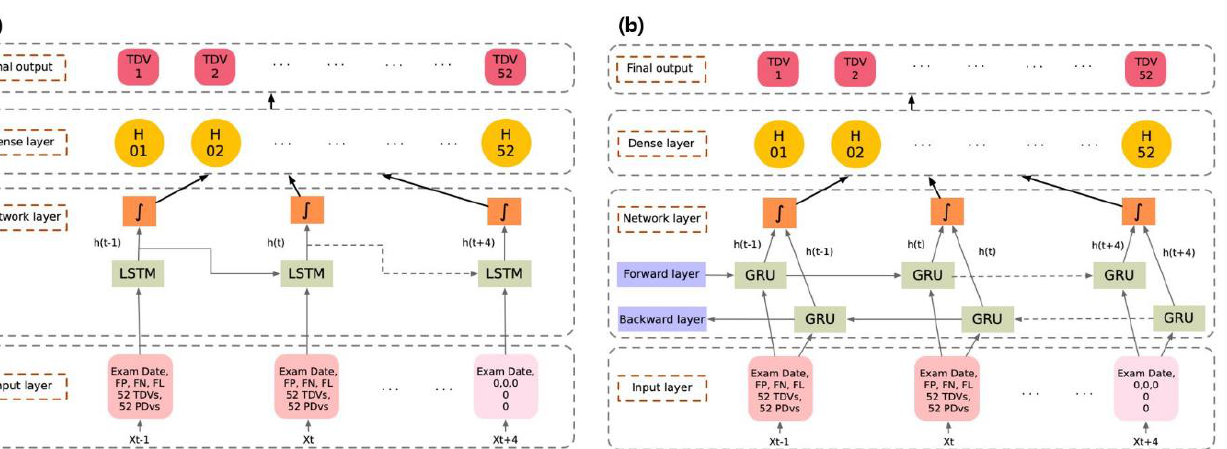
Figure 4. The sequence diagram of the model testing. The sequential convolutional neural model comprised eight parallel HMM or R-CNN units. The architecture of the HMM and R-CNN models are presented in Figure 3a,b, re- spectively.